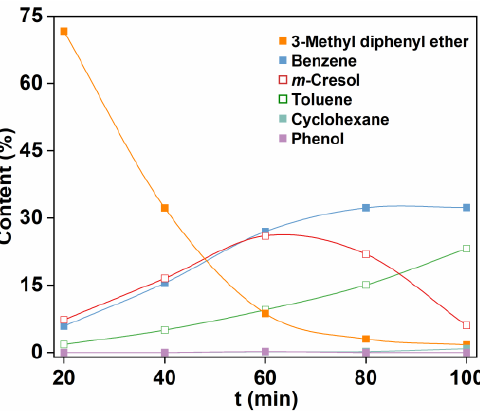
Figure 9. Time profiles of depolymerization of 3-methyl diphenyl over CoRuP/SiO 2 .